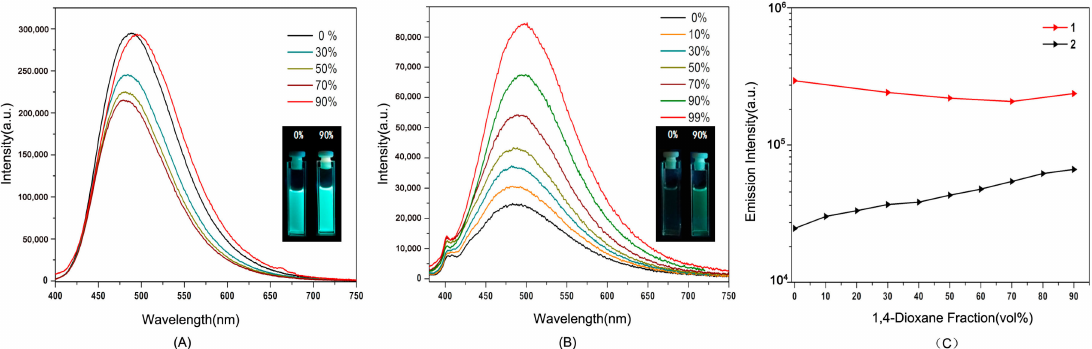
Figure 5. Fluorescence emission spectra of ( A ) 1 , λ ex = 372 nm, ( B ) 2 , λ ex = 358 nm, and ( C ) the plots of maximum emission intensity of assemblies 1 , 2 versus 1,4-dioxane fraction in H 2 O/acetone/1,4-dioxane mixtures. Insert: photographs of assemblies in H 2 O/acetone ( v : v = 1:1) and 90% 1,4-dioxane fractions mixture solution upon excitation at 365 nm using an UV lamp. c L = 50.00 µ